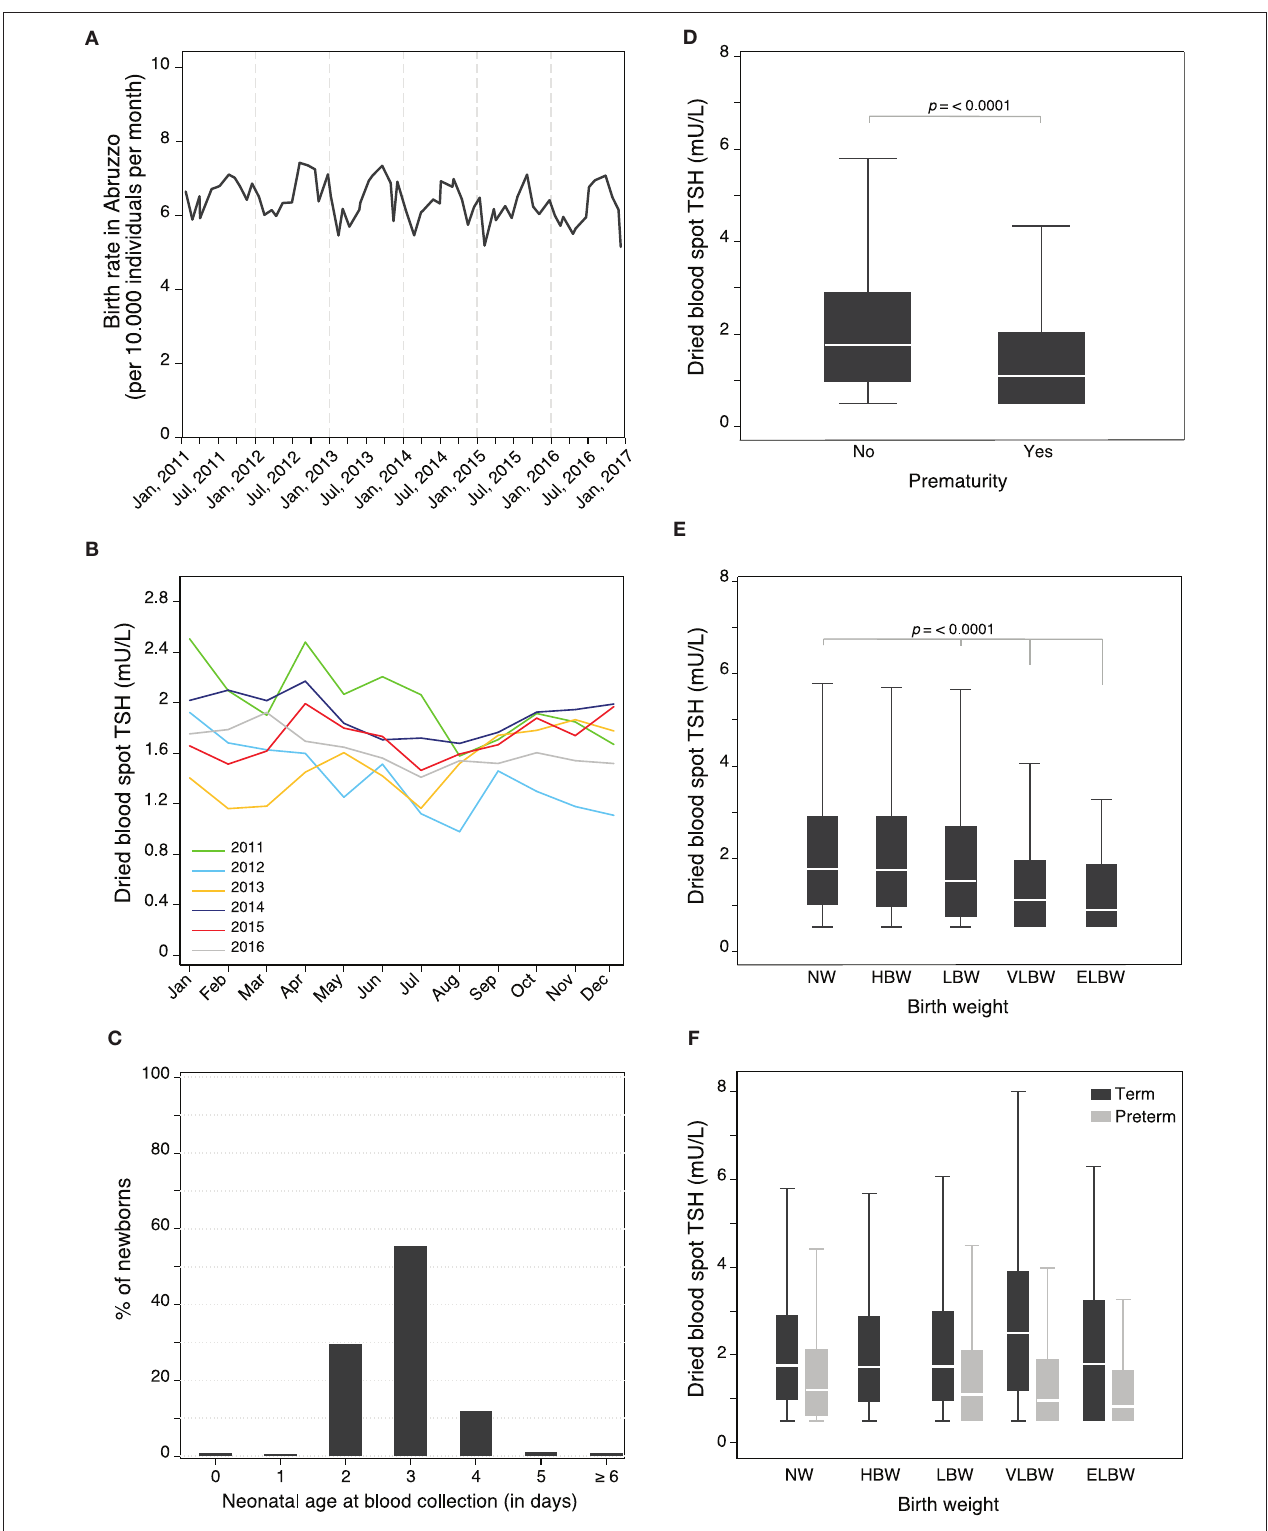
FIGURE 2 | (A) Monthly birth rate in Abruzzo (Italy) between January 1, 2011 and December 31, 2016. (B) Seasonal changes in neonatal TSH during the 6-year study period. (C) Distribution of newborns according to their neonatal age (in days) at blood collection. Individual influence of prematurity (D) , and birth weight (E) on neonatal TSH levels. Influence of birth weight on neonatal TSH levels adjusted for prematurity (F) .